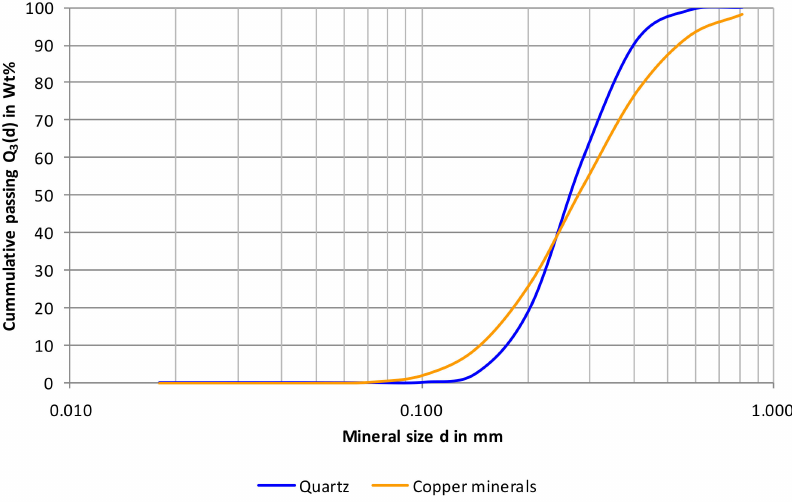
Figure 5. Mineral grain size distribution of the copper ore according to